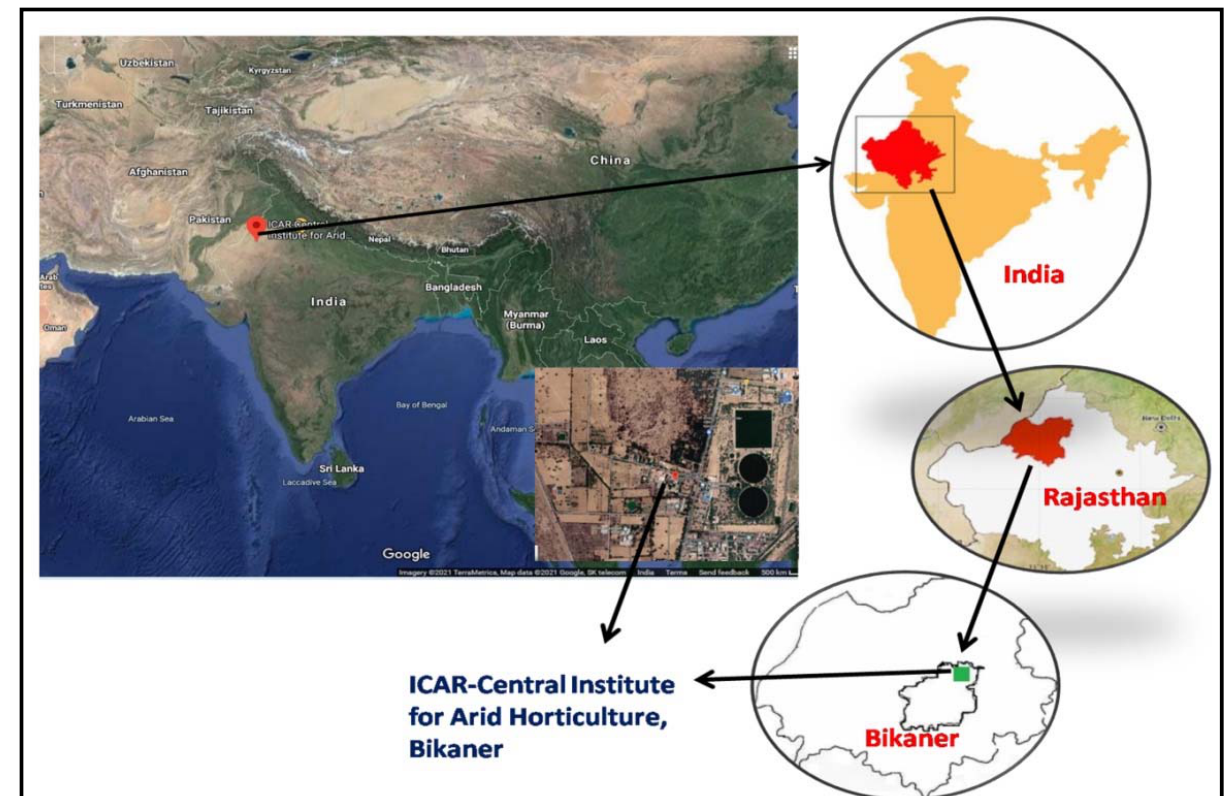
Figure 5. Location map of the experimental site (250 07 ′ 080 N 730 20 ′ 44 ′ E and 217 m above mean sea level) satellite and schematic view.